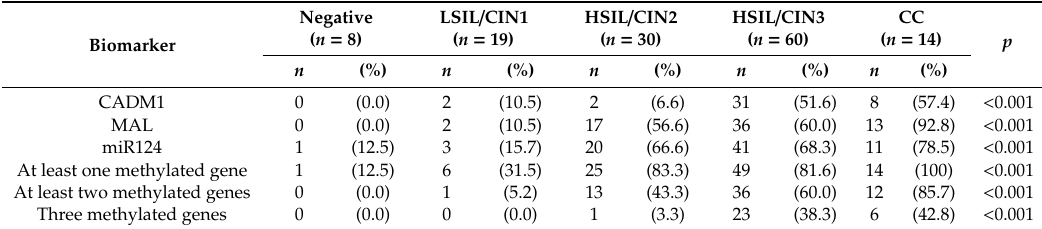
Table 1. Positivity rates for MAL, CADM1, and miR-124 methylation and combinations of at least one, two, or three methylated biomarkers in the di ff erent diagnostic groups. LSIL / CIN1: Low-grade squamous intraepithelial lesion / cervical intraepithelial neoplasia grade 1; HSIL / CIN2: High-grade squamous intraepithelial lesion / cervical intraepithelial neoplasia grade 2; HSIL / CIN3: High-grade